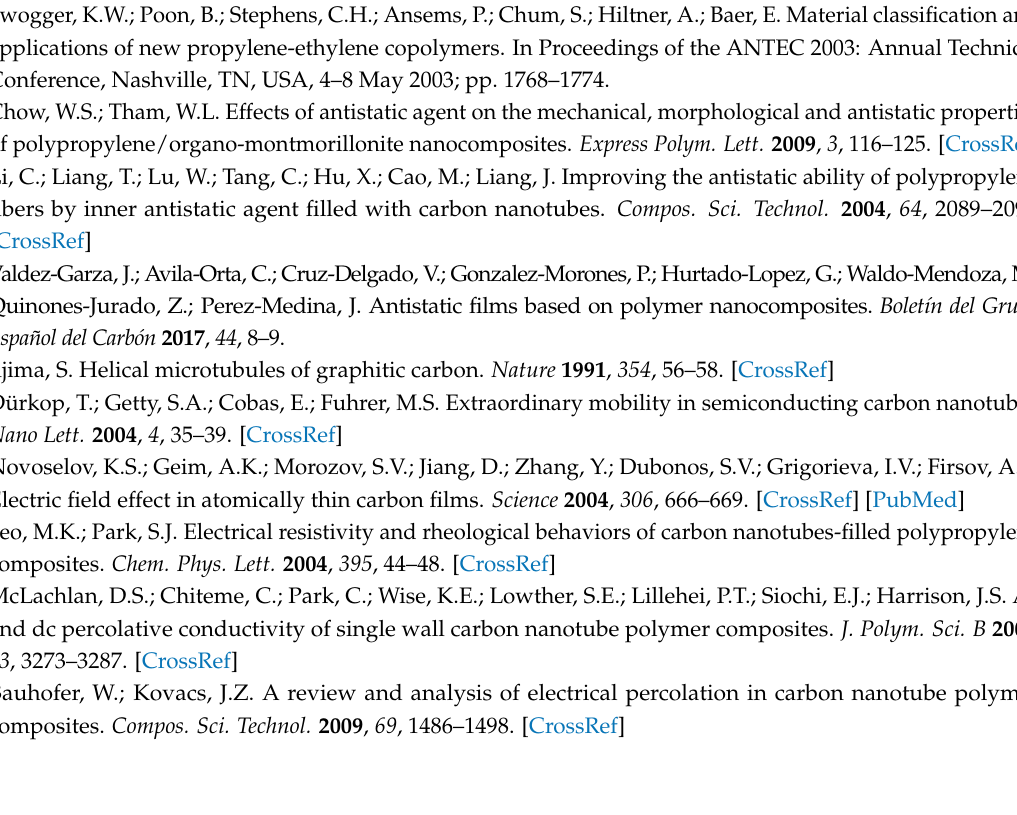
Table S1: Electrostatic charge (kV) prior to unstuck for 3 stacked ABA films fabricated using masterbatches with MFI = 2.5, 34 and 1200 g/10 min. The masterbatches were fabricated using ultrasound-assist methods: W-U, F-U and